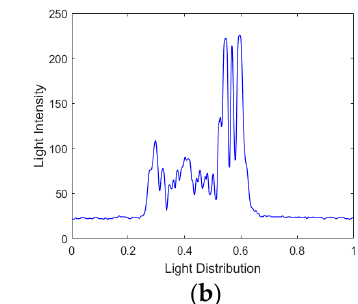
Figure 8. ( a ) The image captured by CCD after correction; ( b ) light intensity distribution. Figure 9. The trend of the performance metric ( a )